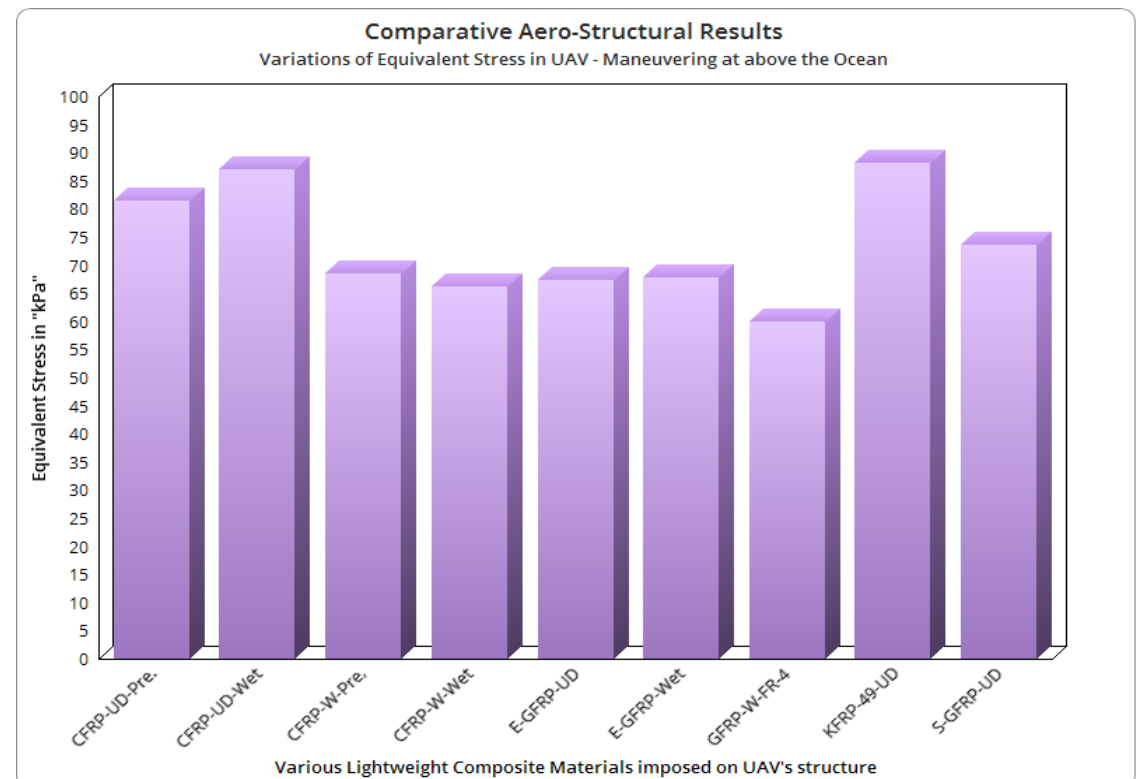
Figure 19. Comparative Equivalent Stress Variations for various composites.